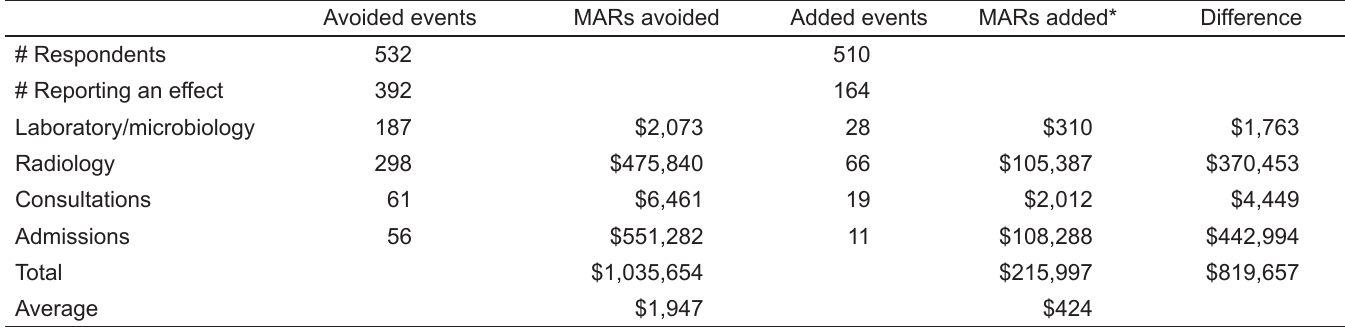
Table. Medicare-allowable reimbersements (MARs) avoided and added.